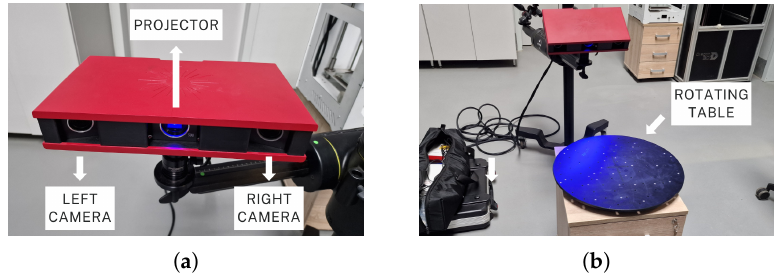
Figure 3. The measurement system with the rotating table ( a ) and the optical scanner ( b ). Table 1. Technical data of ATOS Core 500 (based on [53]). Measuring area